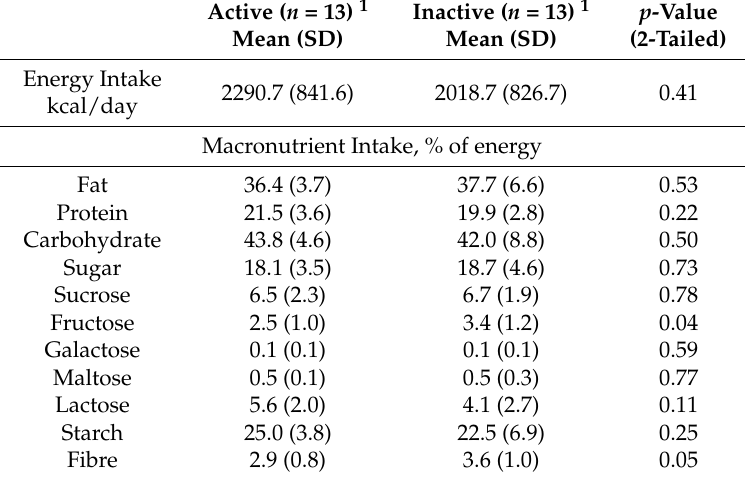
Table 3. Mean energy intake and percentage of energy from macronutrients for active and inactive men (FFQ